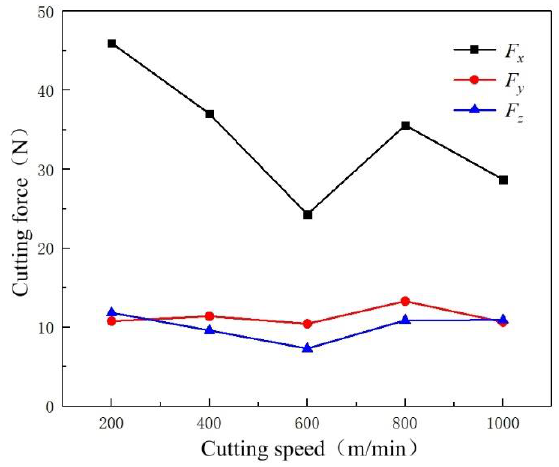
Figure 9. Variation trend of cutting force at different cutting speeds.